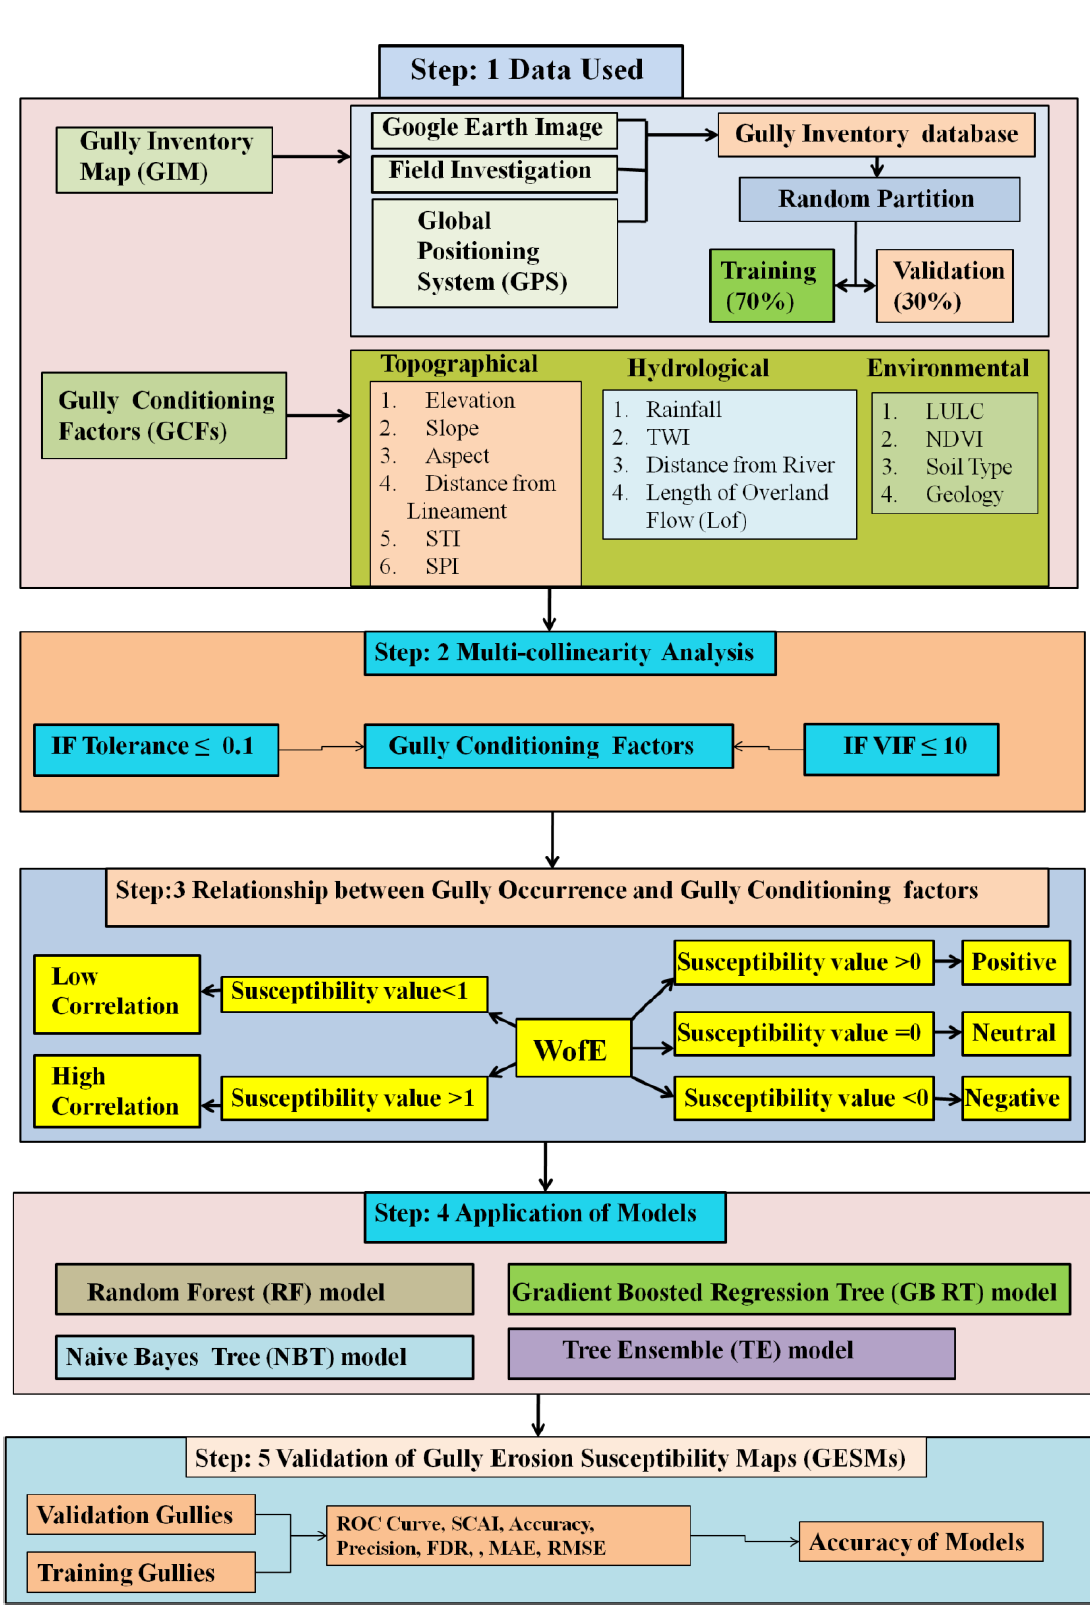
Figure 2. Flowchart showing the methodology of the present work.